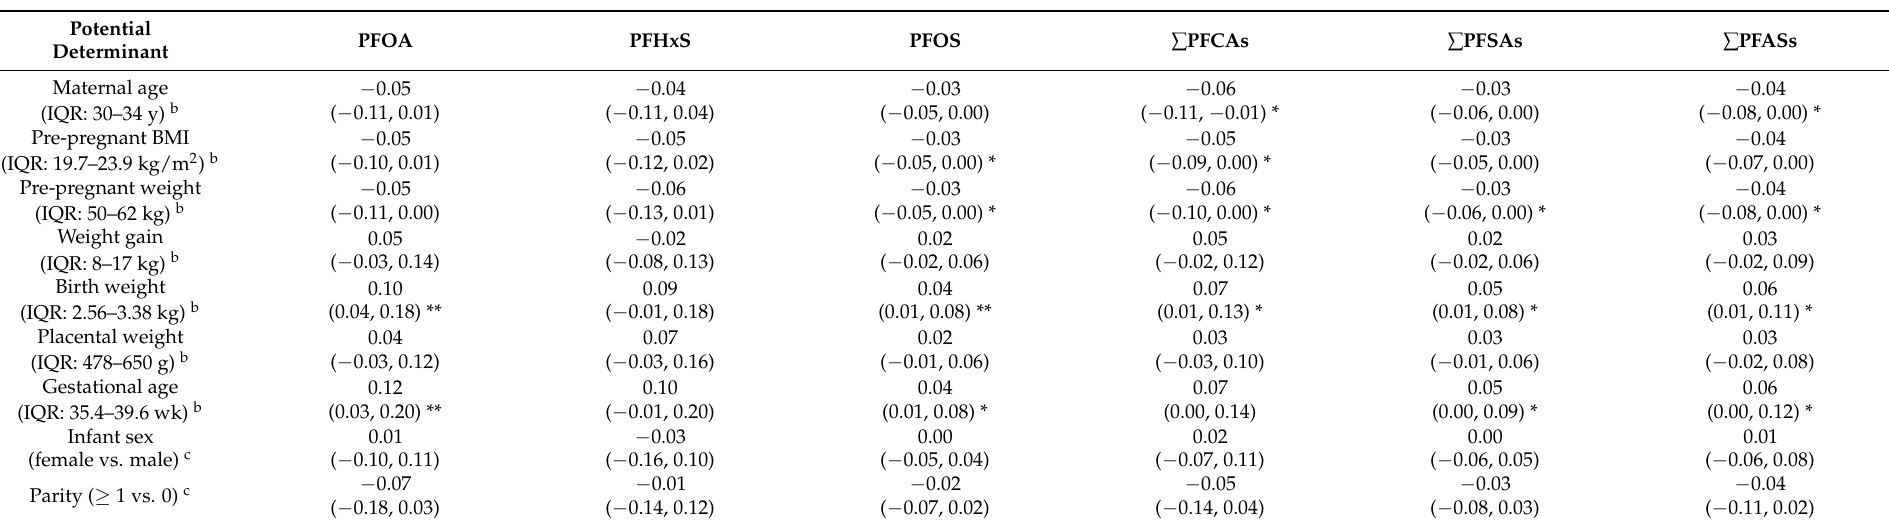
Table 4. Difference (95% CI) in placental transfer rate (cord to maternal serum ratio) of perfluoroalkyl substances (PFASs) associated with potential determinants in the study population ( n = 62) a